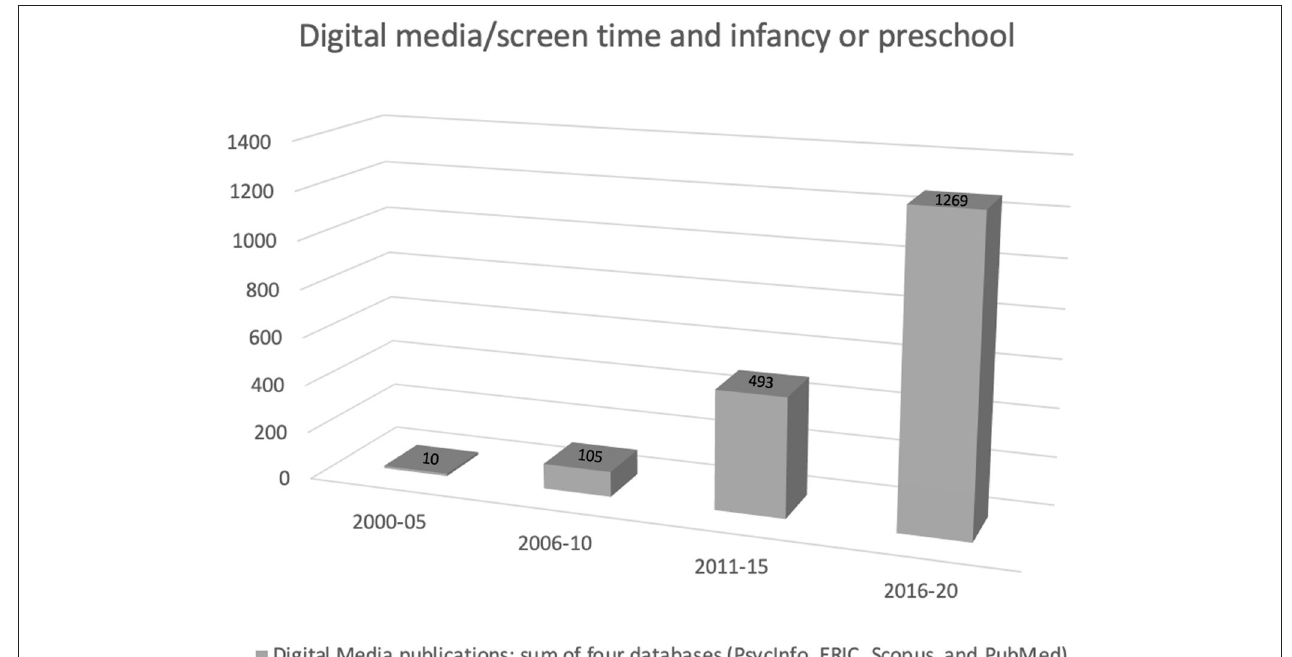
FIGURE 1 | Returned hits from a search combining the terms “digital media” and “screen time” with “preschool” or “infancy.” Search date July 3,